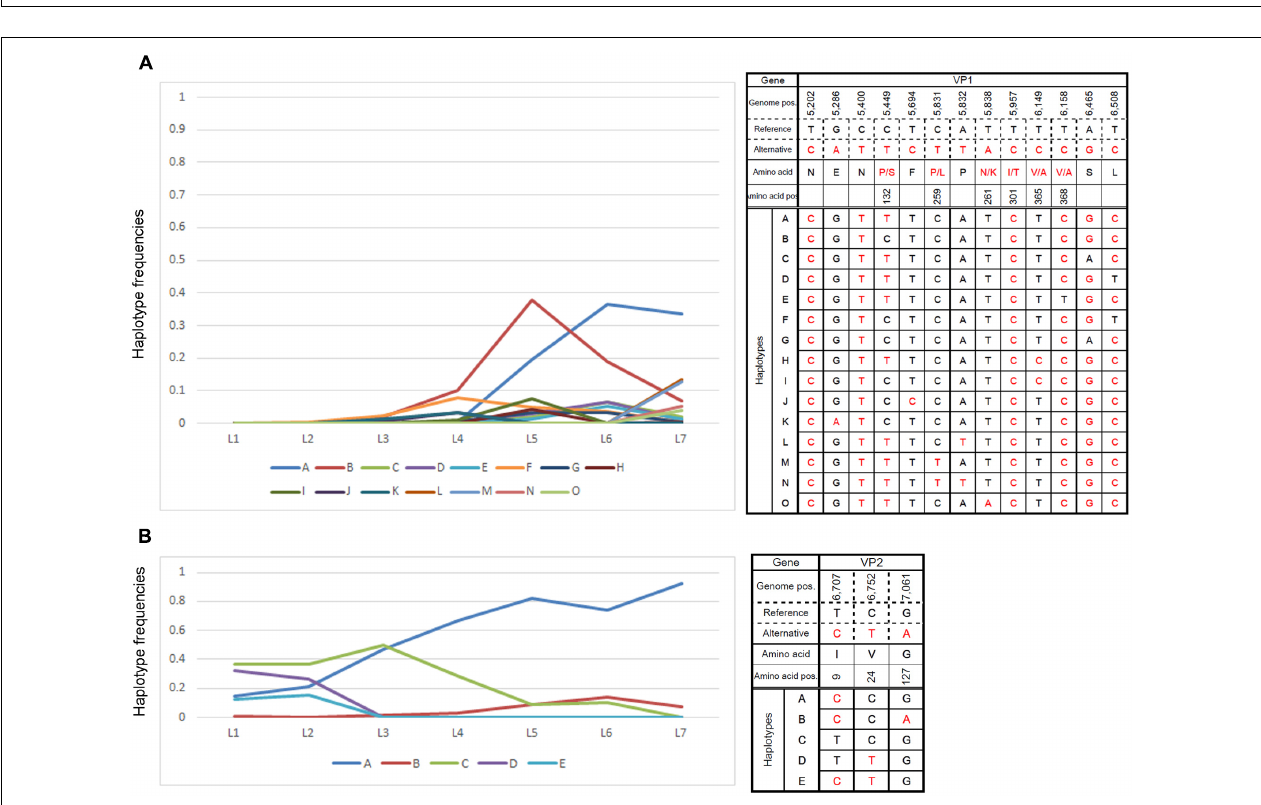
FIGURE 4 | Changes in major haplotype frequencies during each passage. Changes in haplotype frequencies in (A) VP1- and (B) VP2-encoding regions during low-MOI passages were examined by QuasiRecomb using the default setting. Fifteen haplotypes accounted for > 3% of the changes observed in any of the passages were selected and monitored for the frequency of nucleotide changes observed during each passage. The right panels indicate the haplotype sequence along with genome position and possible amino acid change. The left panels show changes in nucleotide frequencies of the selected haplotypes as a line graph. The vertical and horizontal axes indicate the haplotype frequencies and samples for the respective cell passage, respectively.